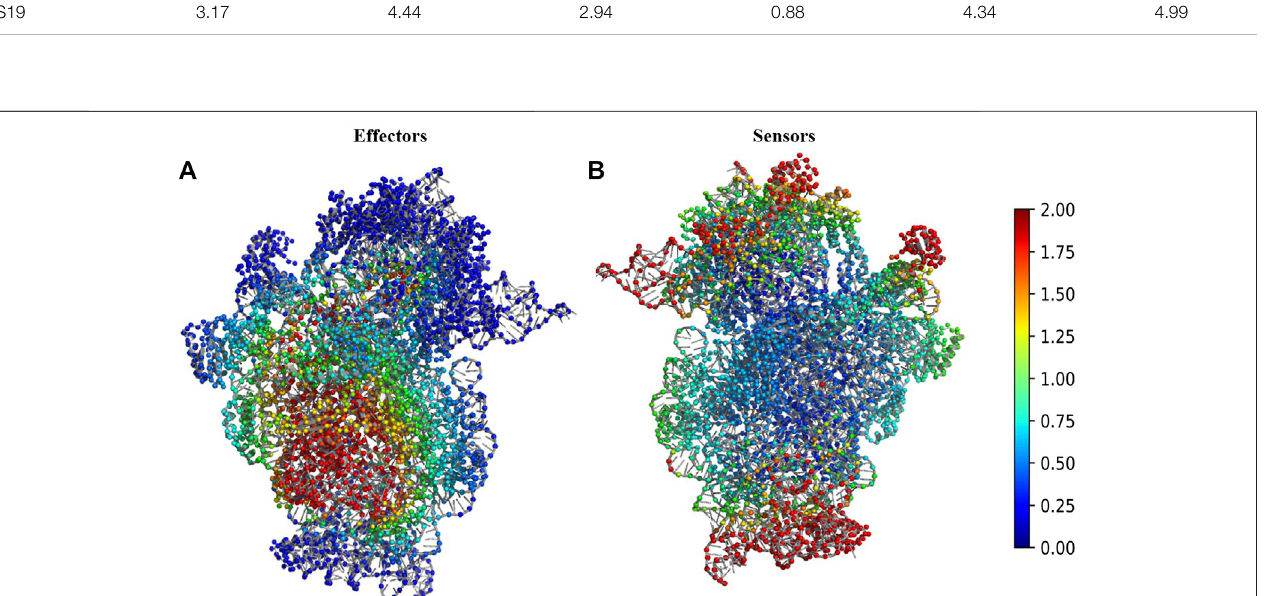
FIGURE2| StructuralmapofthePRSanalysispro fi leof30Sribosomecomplex. (A) Thestructureof30Scomplexisshownincartoon.Regionswerecolourcoded according to their effectiveness values. Residues with effectiveness greater than two are considered as effectors. Red regions depict the strongest effectors and blue regions correspond to the weakest effector sites. (B) The structure of 30S complex is shown in cartoon and regions were colour coded by their sensitivity values in response to perturbation. Residues with sensitivity greater than two are considered as sensors. Red regions are the susceptible sensor sites and blue regions correspond to the most insensitive